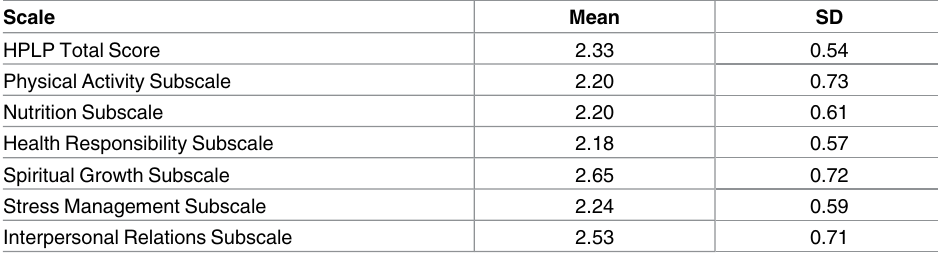
Table 1. Mean and Standard Deviation Scores of HPLP and Subscales.